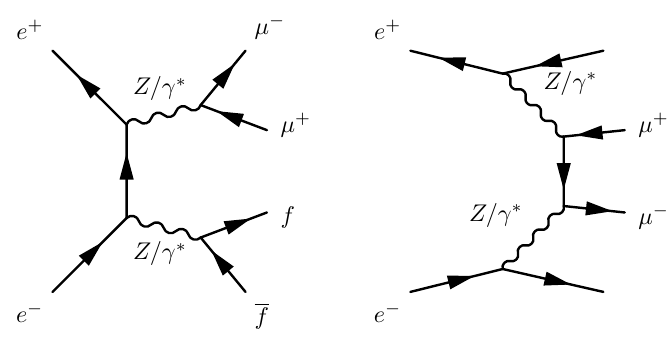
Figure 2 . Example of diagrams contributing signi(cid:12)cantly to the 4 f background. Diagrams such as the one on the left feature kinematics similar to the Zh signal and are resonantly enhanced near the Z poles. Multi-peripheral diagrams such as the one on the right with photons can contribute signi(cid:12)cantly in the small p 2 regime due to collinear singularities. These multi-peripheral dia- Z=(cid:13) (cid:3) grams are double counted if one naively includes both the total 4 f background and (cid:13)(cid:13) (cid:22) + (cid:22) (cid:0) ! background (in the equivalent photon approximation) without appropriate kinematic